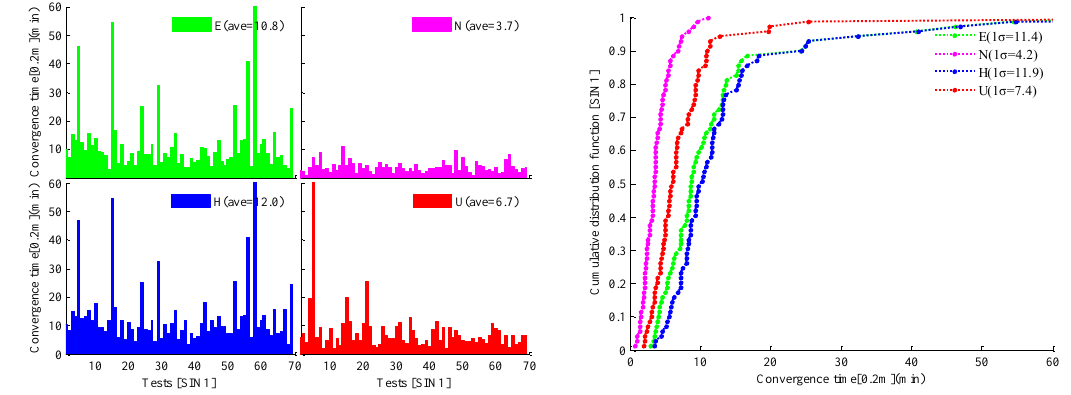
Figure 6. The convergence time for the 20-cm level for SIN1 ( left : bar series; right : CDF curve).